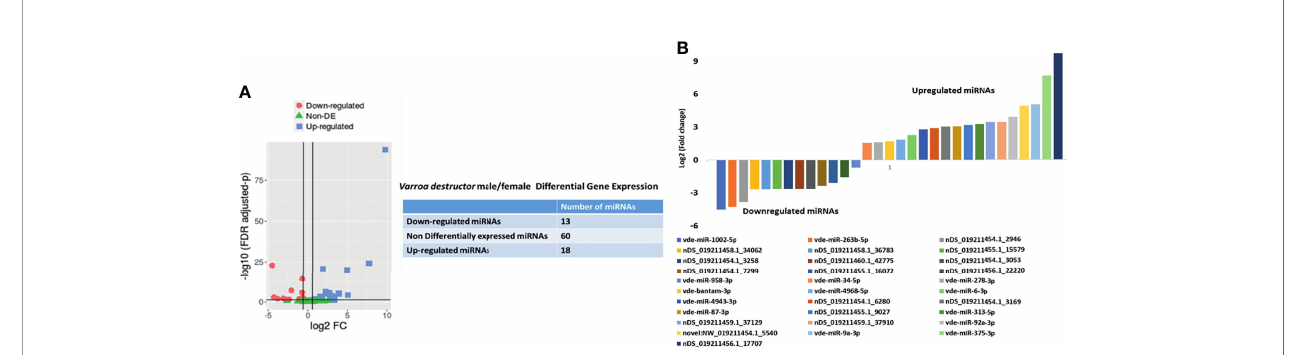
FIGURE 3 | (A) In silico differential expression analysis of predicted microRNAs in female Varroa destructor relative to males. EdgeR was used for differential expression analysis. 13 predicted microRNAs were downregulated, 18 upregulated, and 60 were unaffected. (B) Differential expression of individual microRNAs in Varroa females relative to males. miRNAs with a log2 fold-change expression > |1| and FDR ≤ 0.1 were considered signi fi cantly differentially expressed with respect to male miRNAs (refer to Table